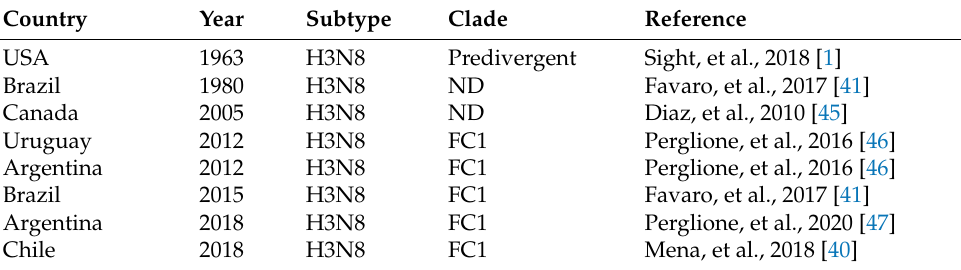
Table 1. Characterization of EIV outbreaks in the